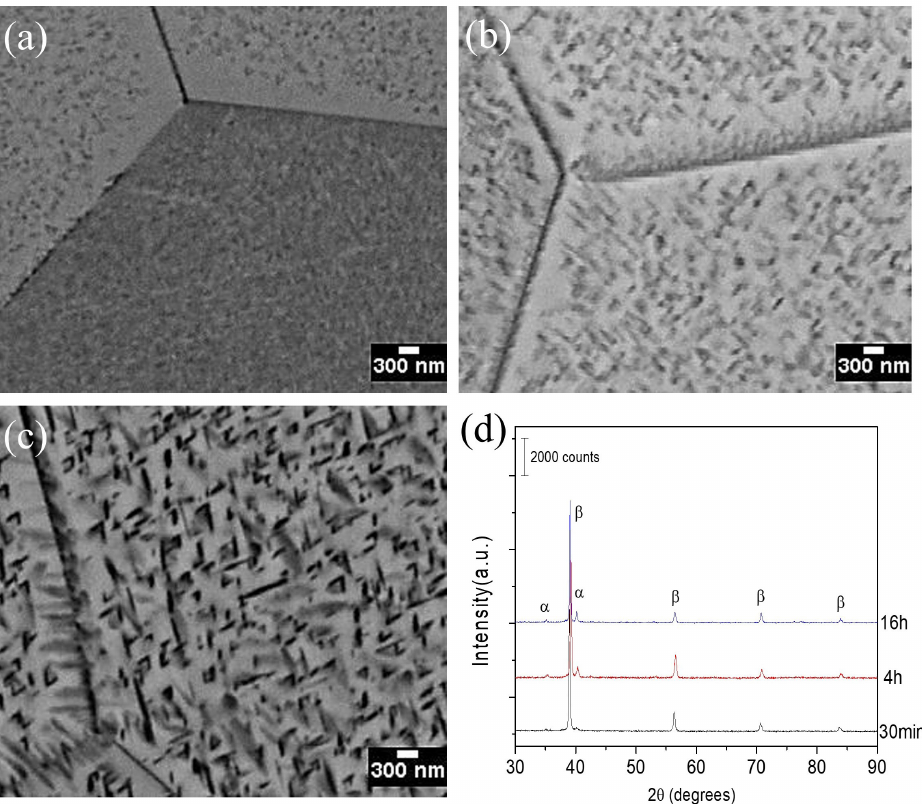
Figure 8. Microstructures of Ti-30Nb-3Fe alloy treated at 500 ºC, applying a heating rate of 1 ºC/min for (a) 30 min, (b) 4 h, and (c) 16 h. (d) XRD patterns of each of the aged samples. SEM micrographs of unetched samples recorded in backscattered electron imaging